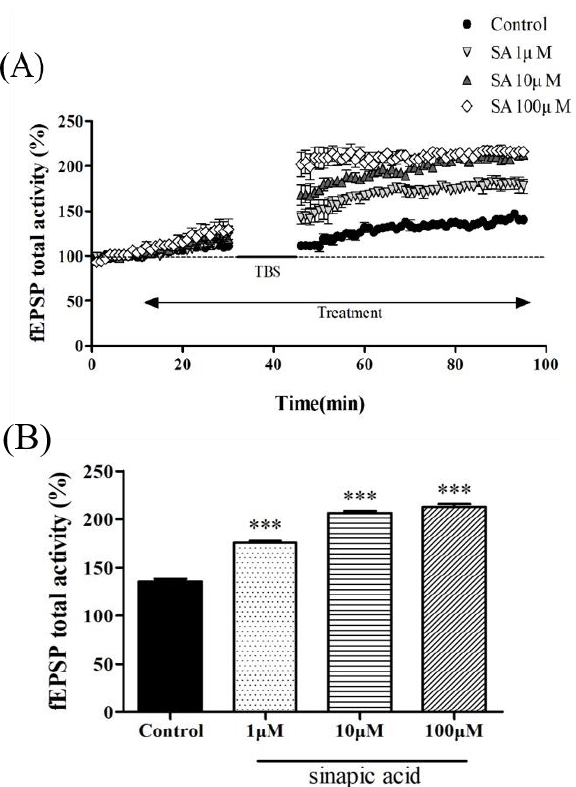
Figure 2. The effect of SA on long-term potentiation of the hippocampus. ( A ) fEPSP total activity (%) induced by TBS while treatment of SA in the organotypic cultured hippocampus. ( B ) Average of fEPSP total activity of organotypic cultured hippocampus treated with SA (1, 10, and 100 µ M) between 30 to 40 min after TBS. n = 4. *** p < 0.001 versus the control group. Analyzed by one-way ANOVA with LSD test.